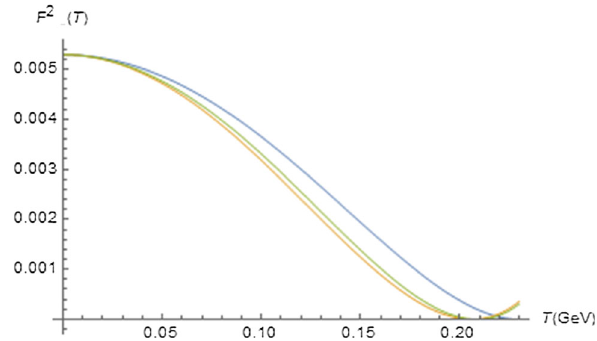
Fig. 5 Temperaturedependence ofthe F 2 a 2, F = 87 MeV (orange line); N f = 3, F = 100 MeV (green line); N f = 5, F = 140 MeV (blue